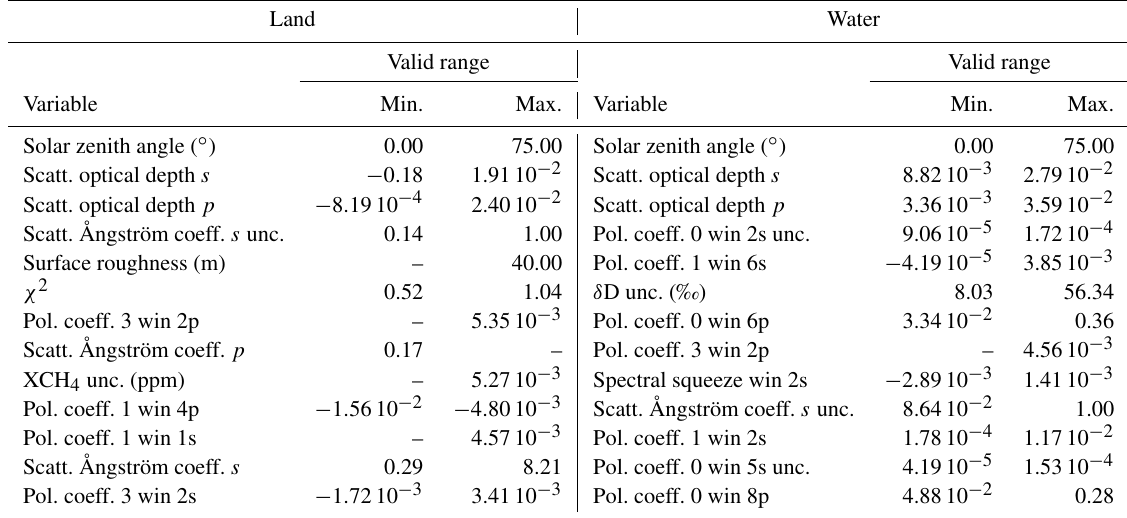
Table A7. XCH 4 filter variables and limits for GOSAT-2. “–” means that no limit is applied. Except for the solar zenith angle limits, the variables are ordered by their relevance, i.e. by the number of data filtered